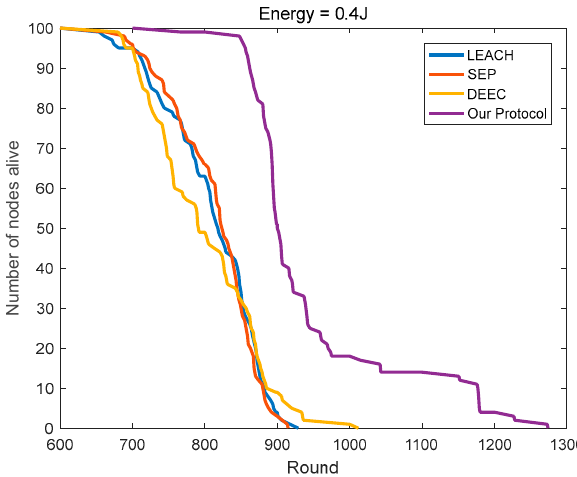
Figure 14. The number of surviving nodes varies with the round (initial energy = 0.4 J).